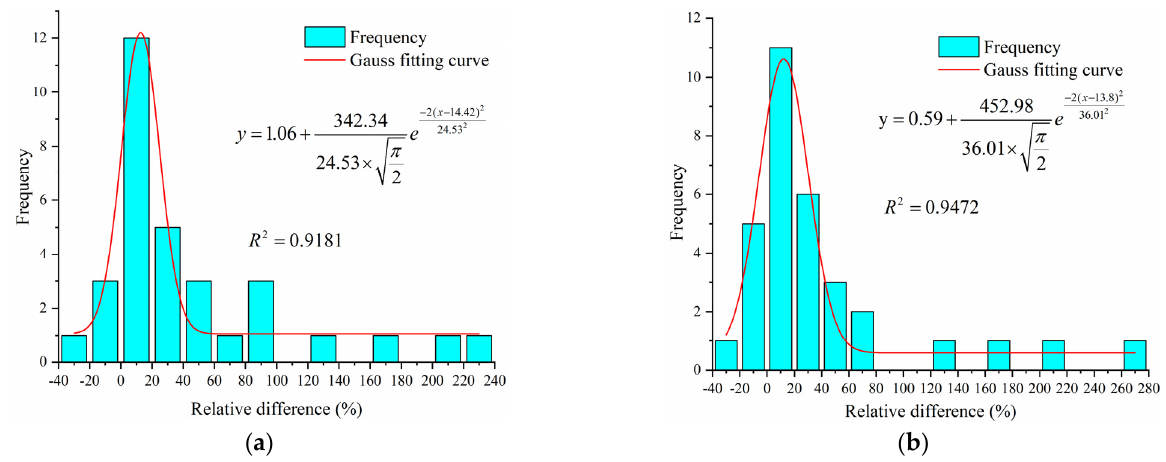
Figure 4. Relative difference frequency distribution and Gauss fitting curve ( a ) TN ( b ) TP.